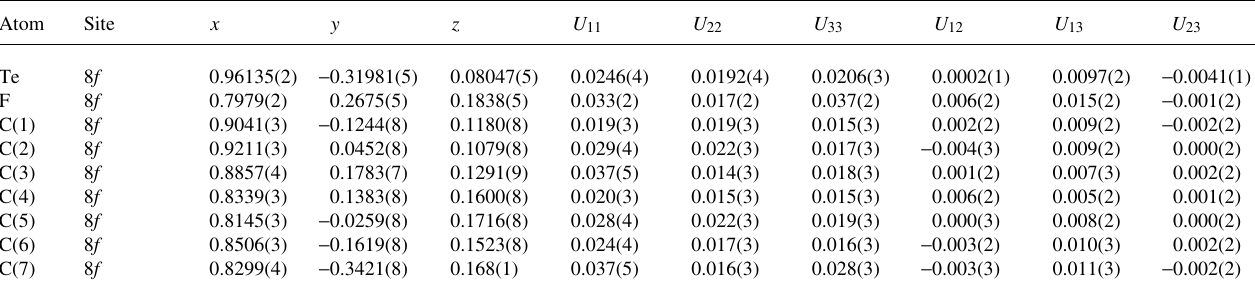
Table 3. Atomic coordinates and displacement parameters (in Å 2 )